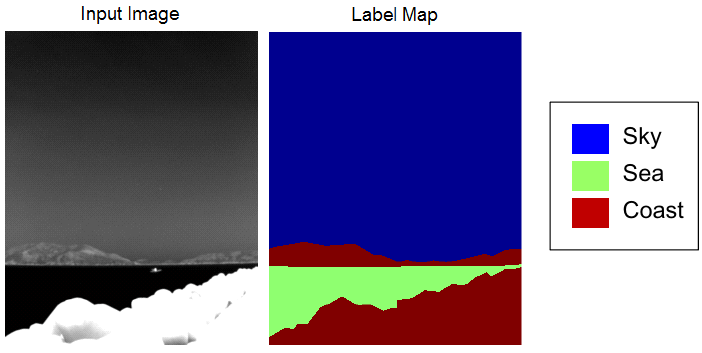
Figure 5. Example of the prepared test DB for a quantitative